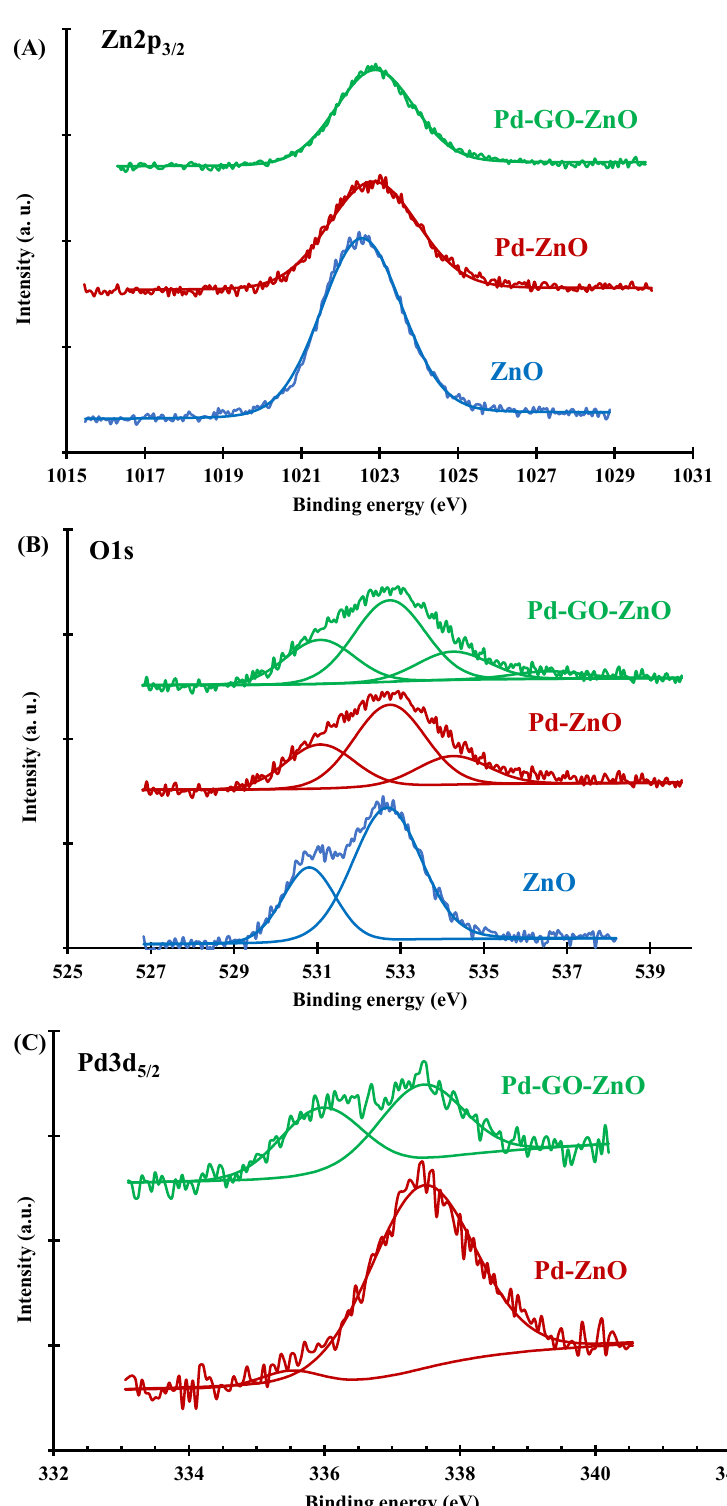
Figure 7. XPS high resolution spectra ( A ) Zn2p 3/2 ; ( B ) O 1s; ( C ) Pd3d 5/2 .